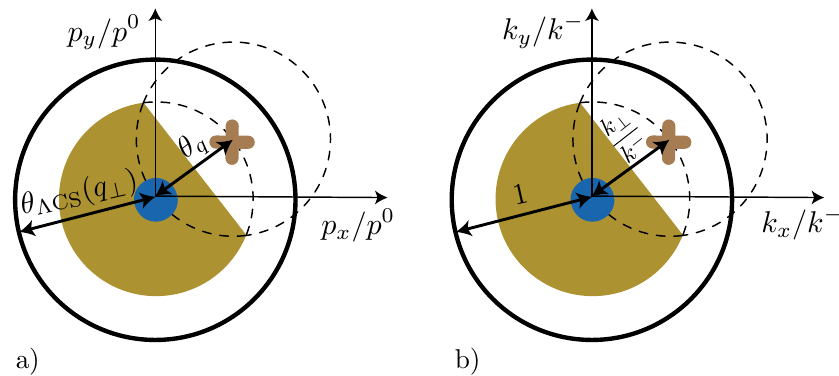
Figure 14 . The catchment area of nonperturbative modes in the SDNP region is shown. The brown cross indicates a NP subjet that stops soft drop in the SDNP region and has an angle (cid:18) q < (cid:18) (cid:3)CS ( q ). Blue dot refers to the collinear parton aligned with the jet axis. The brown shaded ? region corresponds to the region where any other NP subjets could lie clustered with the collinear subjet. In b) the same geometry is shown in the rescaled